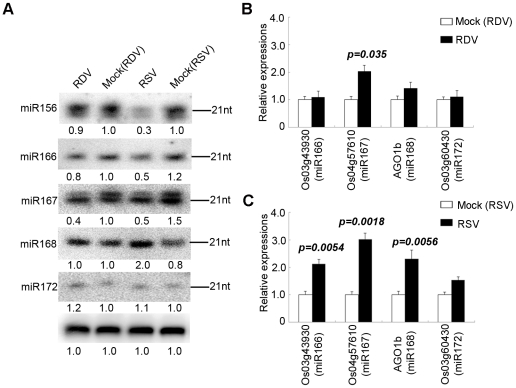
Confirmation of miRNA expression and analysis of miRNA target gene expression of in virus-infected plants.(A) RNA gel blots showing expression of miR156, miR164, miR166, miR167, miR168 and miR172 in virus infected rice plants. Rice U6 was reprobed as a control. The expression levels from mock (RDV)-inoculated plants are set to a value of 1.00 and the other three plants are expressed relative to this reference value. (B) Expression analysis of miRNA targets from RDV-infected plants and (C) from RSV-infected plants by quantitative real-time RT-PCR analysis. The expression levels of the assayed genes were normalized to the expression level of OsEF-1α.Os12g41680, Os03g43930, Os04g57610 and Os03g60430 are the targets of miR164, miR166, miR167 and miR172, respectively [54].